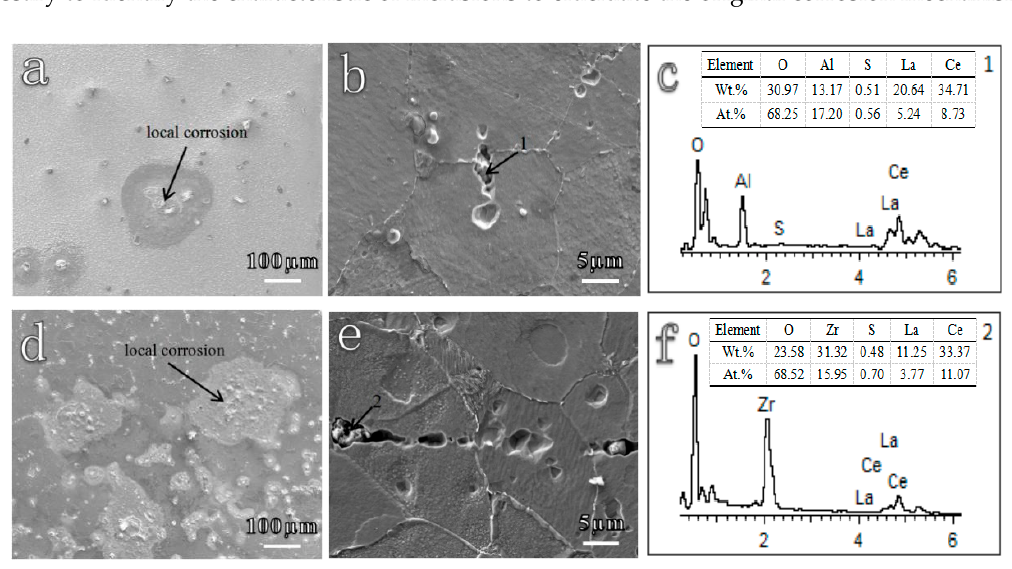
Figure 3. Corrosion morphologies of ( a , b ) Al deoxidized steel and ( d , e ) Ti / Zr deoxidized steel after immersion in 0.5 wt.% NaCl solution for a few minutes. ( a , d ) One hour, ( b , e ) 10 min, ( c , f ) EDS results of inclusions marked in b and e